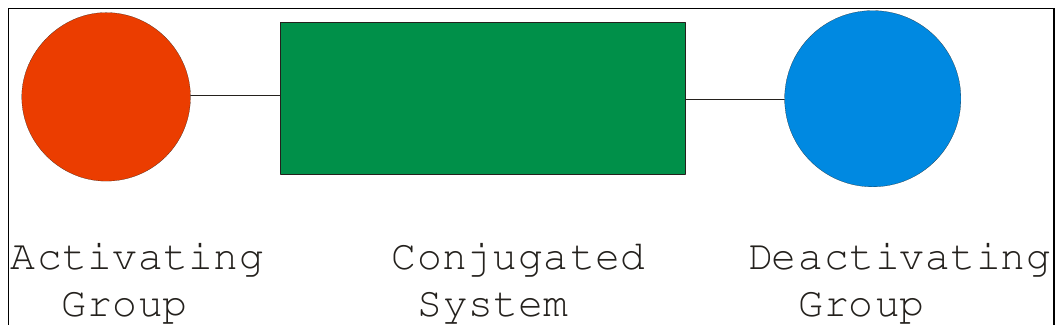
Figure 1. Schematic NLO conjugated